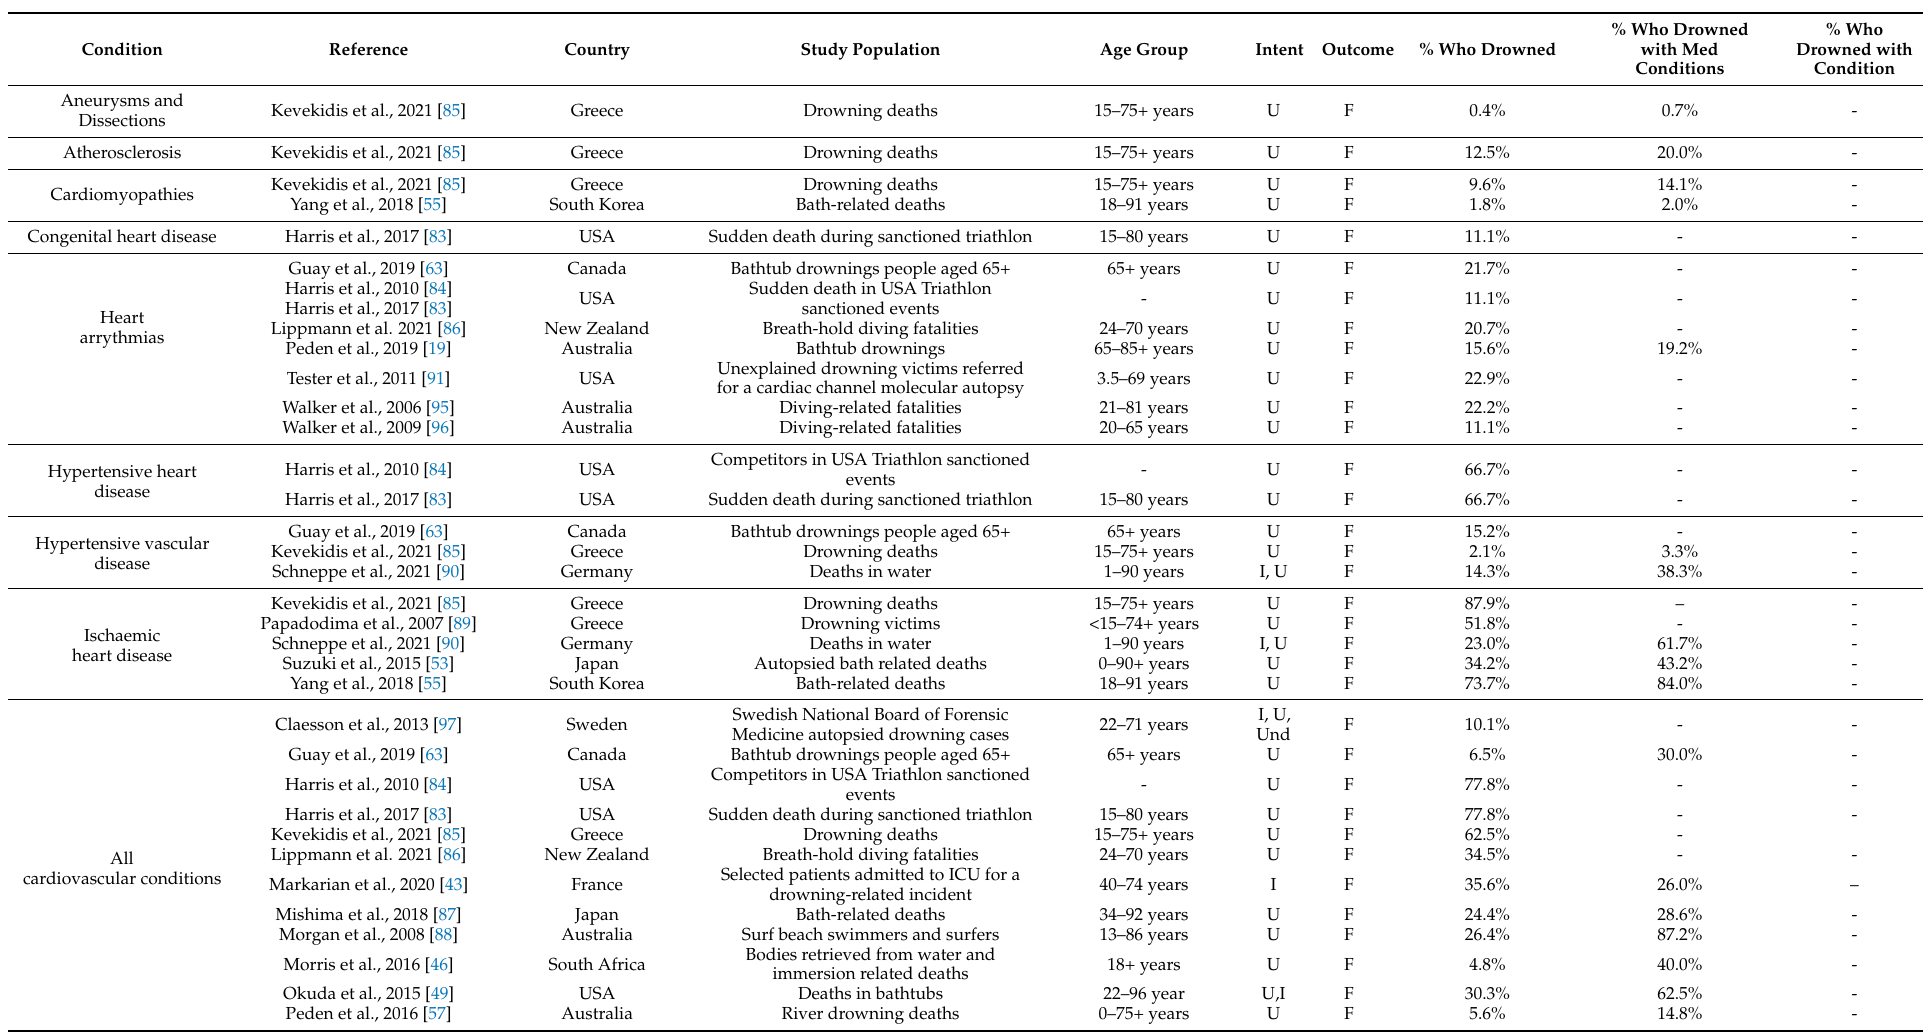
Table 6. Studies reporting conditions within the diseases of the circulatory system